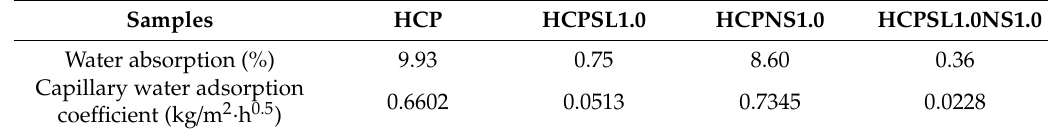
Table 2. Summary of water absorption and capillary water adsorption coe ffi cient of